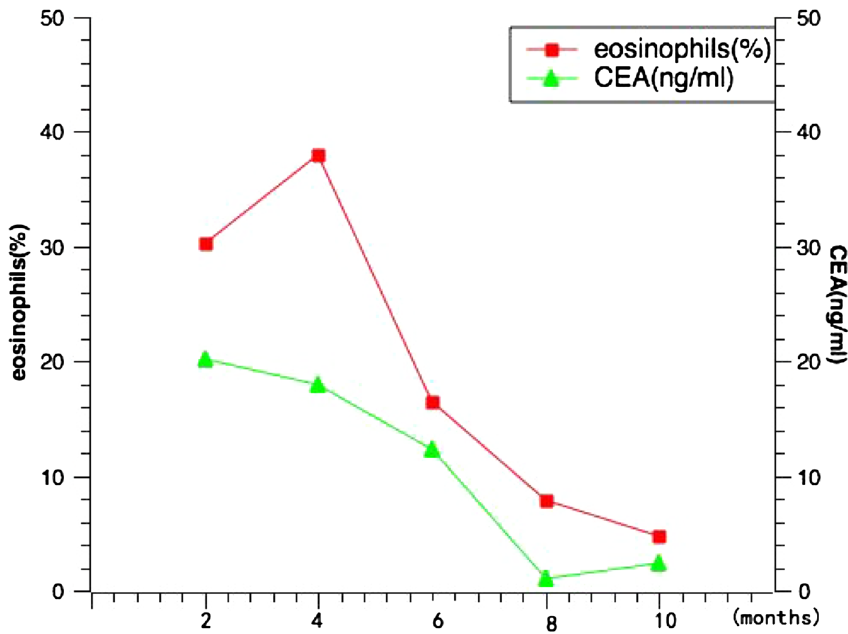
Figure 2. The relationship between CEA and eosinophils in this patient.